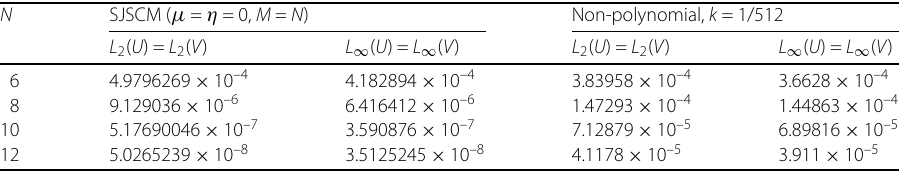
Table 5 L 2 and L ∞ error norms for u ( x , t ) = v ( x , t ) of Example 1 when 0 ≤ x ≤ 3, α 1 = α 2 = 0.4